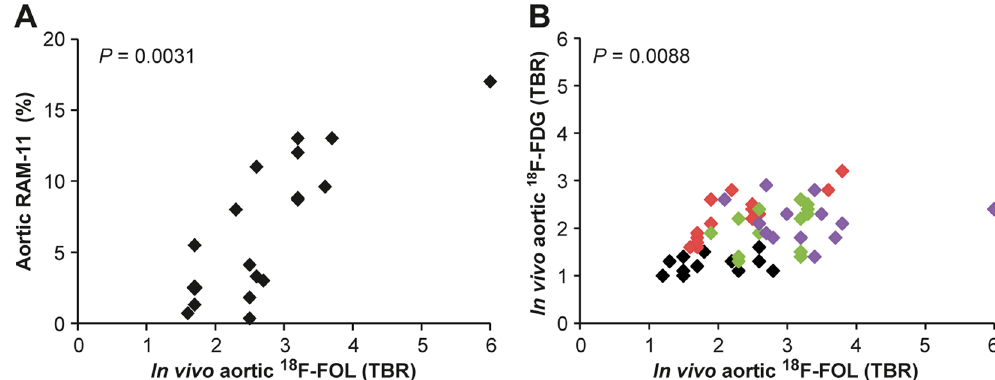
Figure 6. 18 F-FOL and 18 F-FDG uptake, and density of macrophages in rabbit aorta. Association between in vivo 18 F-FOL uptake in the rabbit aorta and ( A ) RAM-11-positive (macrophages) area (%; linear mixed model; slope = 3.82, 95% confidence interval of 1.60 to 6.05), and ( B ) 18 F-FDG uptake (linear mixed model; slope = 0.22, 95% confidence interval of 0.058 to 0.38). The data of each rabbit are displayed in a different color. TBR = target-to-background ratio; maximum standardized uptake value (SUV) of aorta divided by mean SUV of blood as determined from the inferior vena cava (SUV max, aorta /SUV mean, blood ).